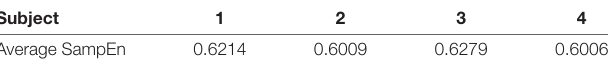
TABLE 2 | Average SampEn for each subject.